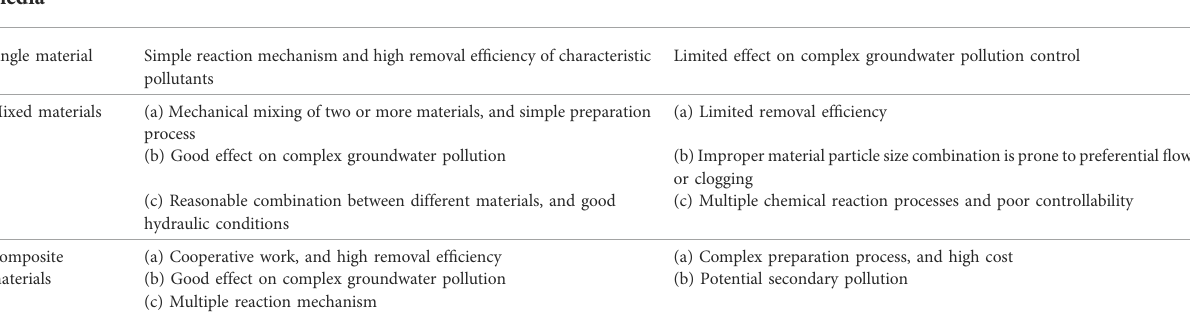
TABLE 8 Comparison of advantages and disadvantages of three types of reaction